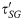
The fixation time as a function of the mutation rate μ.With the rise of μ, fixation time needed becomes shorter. In each panel, fixation time of strategies in threshold PGG models with an insurance compensation and without one, and the standard PGG model without a threshold are respectively shown and compared. (a) A mutant G invades S and L population. τSG and τLG are the average time starting in pure state of S and L to reach G, respectively, in the threshold PGG model with an insurance compensation. Likely, τSG′ and τLG′ are the fixation time for the threshold PGG model without an insurance compensation. Besides, τSG* and τLG* are the fixation time for the standard PGG model without a threshold. It is shown that τSG (and τLG) are shorter than τSG′ (and τLG′) and τSG* (and τLG*). (b) A mutant L invades S and G population. (c) A mutant S invades L and G population. Comparing the three panels, it is shown that the fixation time of G strategy is longer than that of L and S, and the fixation time of S is the shortest in the same model. The introduction of threshold and insurance compensation into PGG evidently shortens the fixation time of global cooperation strategy. Parameter values are: N = 100, M = 20, r1 = 2, r2 = 3, s = 200, q = 0.8, ϕ = 0.5 and ω1 = ω2 = 0.05.